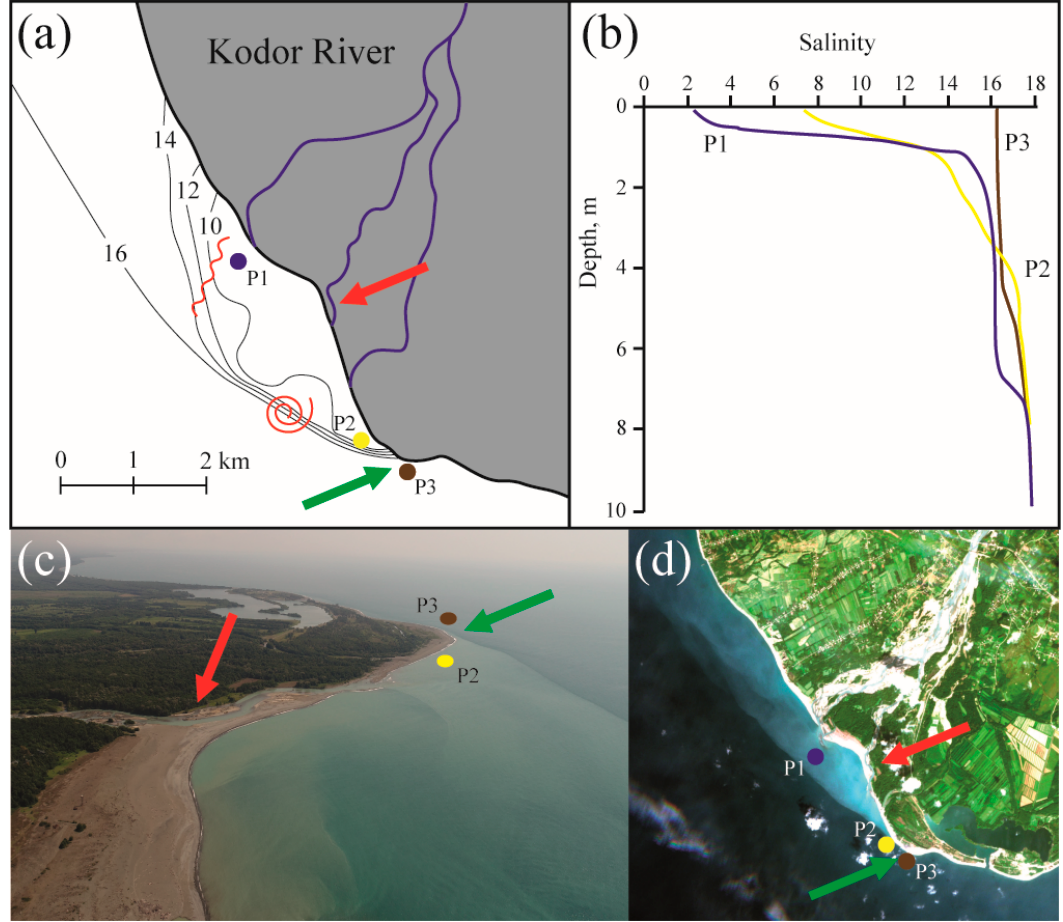
Figure 3. ( a ) surface salinity distribution, ( b ) vertical salinity profiles, ( c ) aerial image (acquisition time 13:29), and ( d ) Sentinel-2 ocean color composite of the Kodor plume from 31 August 2018. Color dots indicate locations of vertical salinity measurements (1, blue—near the river mouth; 2, yellow—near the plume border, and 3, brown—at the ambient saline sea). Red arrows indicate location of the central deltaic branch of the Kodor River, green arrows indicate location of the Iskuria Cape. The red swirl at panel ( a ) indicates location of the eddy detected on 1 September, 2018 (see Figures 7–9). The red wave line at panel ( a ) indicates location of the undulate (lobe-cleft) plume border detected on 1 September 2018 (see Figures